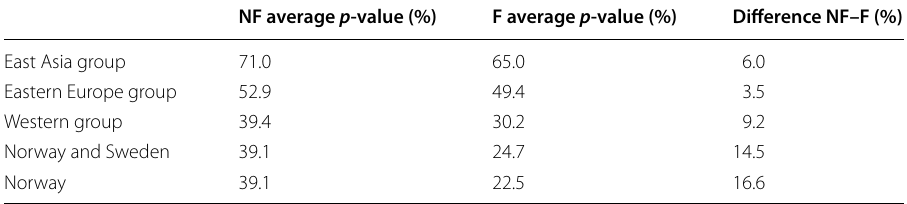
Table 6 Average p -values for the NF and F item categories in TIMSS 2011 grade 8 math-